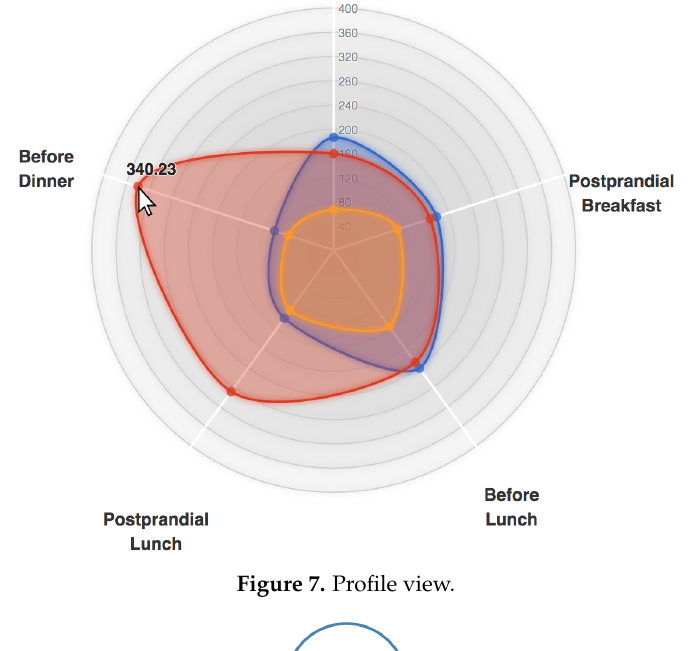
Figure 7. Profile view.